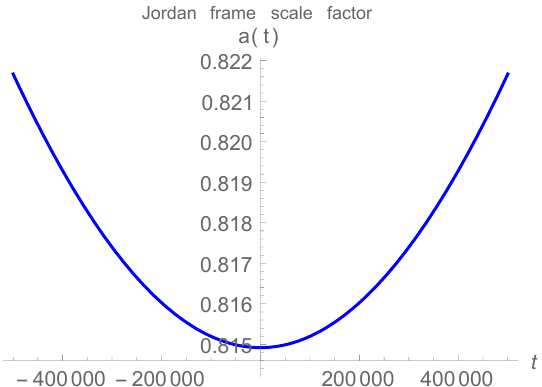
Figure 2. Time evolution of the scale factor in the Jordan frame for a bounce in radiation background in exponential gravity found with the initial conditions φ ( 0 ) = 0.1, φ (cid:48) ( 0 ) = 0, ˜ H ( 0 ) =